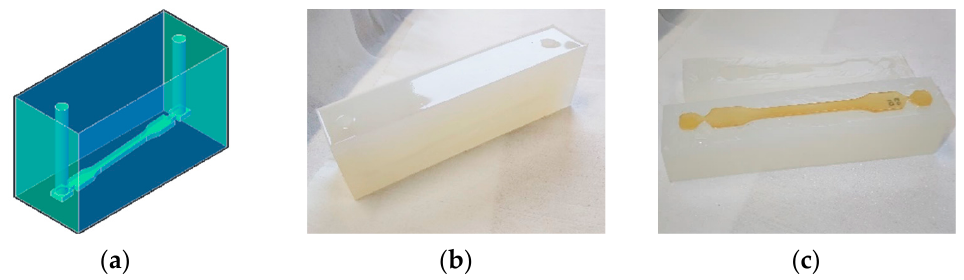
Figure 3. Molds developed for the casting of a polymerizing mixture with low initial viscosity and subsequent shrinkage: ( a ) conceptual representation of the structure of the inside cavity, ( b ) picture of a closed silicone mold, and ( c ) picture of an open silicone mold with a final specimen.